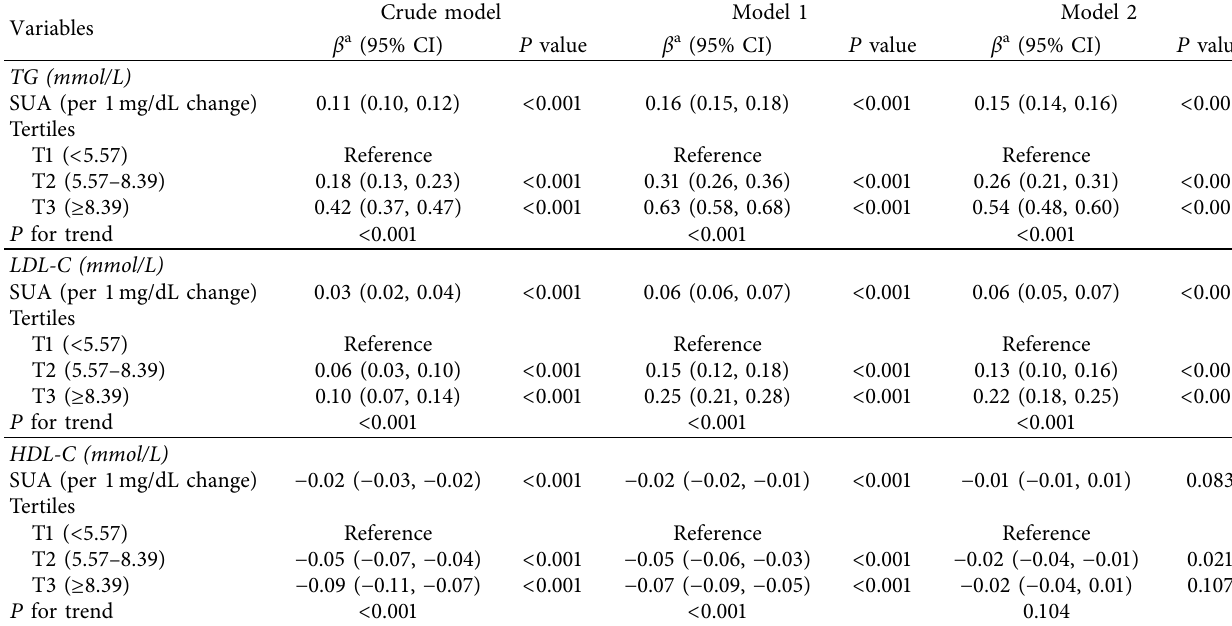
Table 2: Association between SUA and